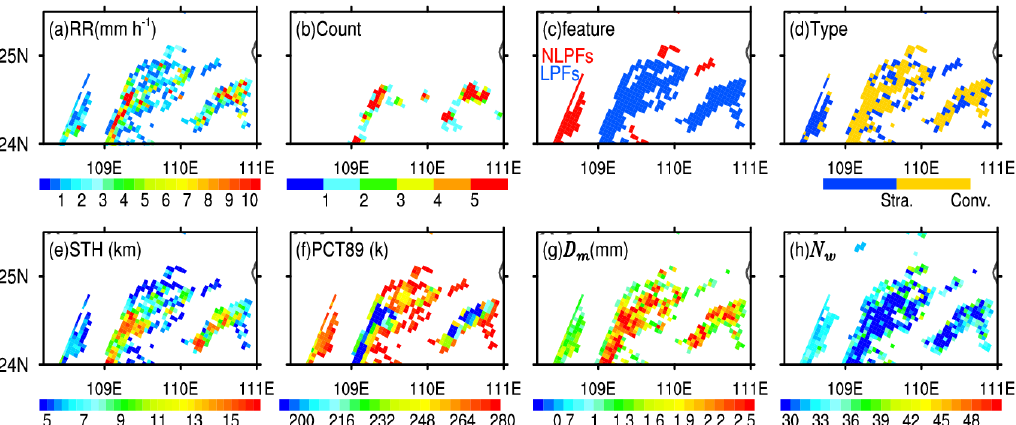
Figure 1. An example of precipitation features observed by GPM satellite. ( a ) Near-surface RR, ( b ) lightning flashes, ( c ) classifications of LPF and NLPF areas with blue (red) contiguous rainy pixels representing LPFs (NLPFs), ( d ) rain type, ( e ) storm-top height, ( f ) PCT89, ( g ) D m at 2 km altitude and ( h ) N w at 2 km above the MSL.